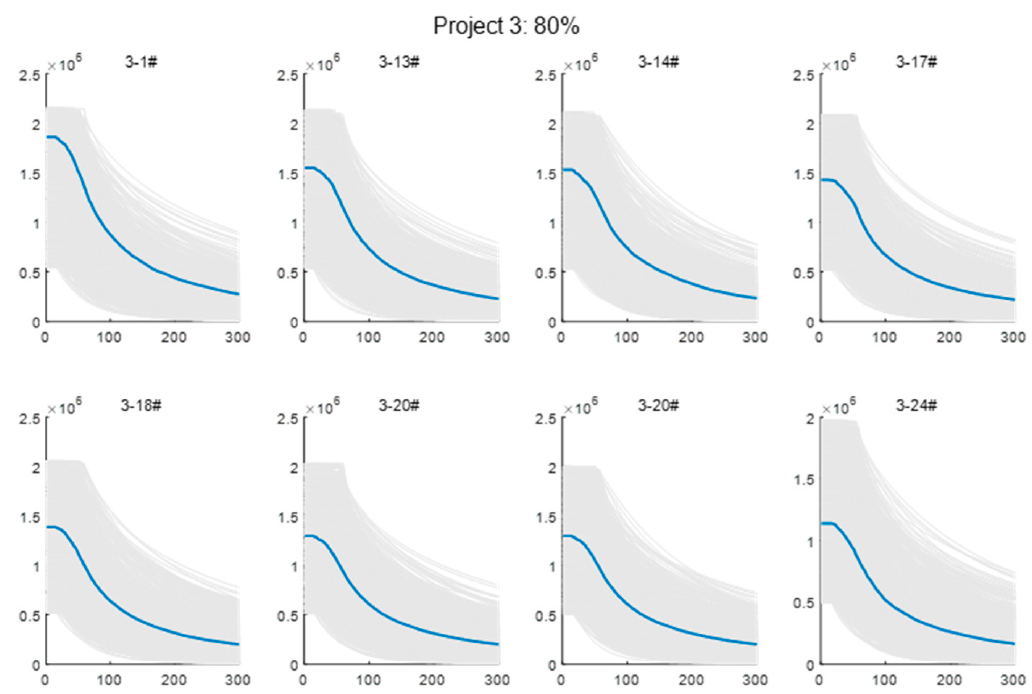
Figure 6. Production plan of project 3.